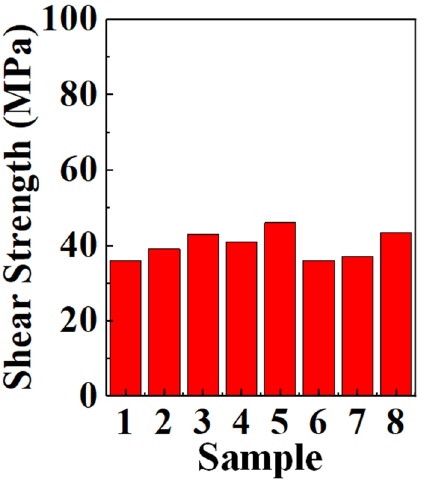
Figure 6. Shear strength of the PI bonding